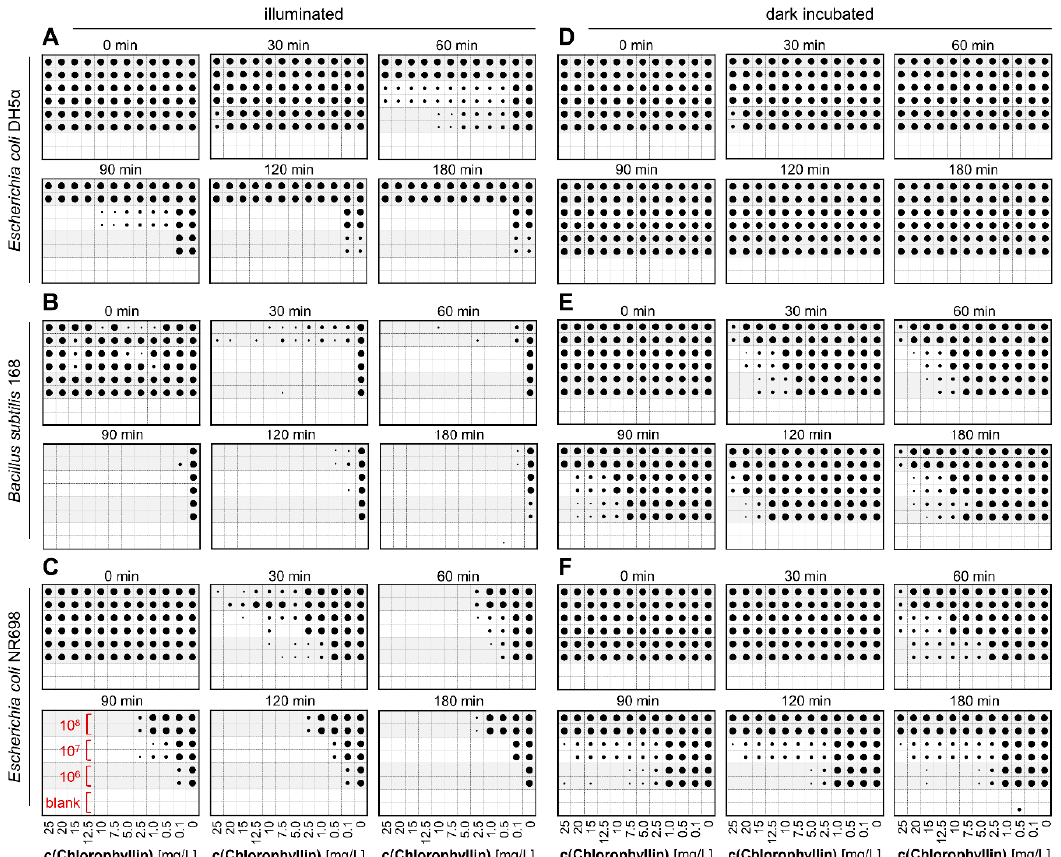
Figure 4. Schematic presentation of evaluation of CFU ability after incubation to chlorophyllin. Differently dense liquid cultures of ( A ) Escherichia coli DH5 α , ( B ) Bacillus subtilis 168, and ( C